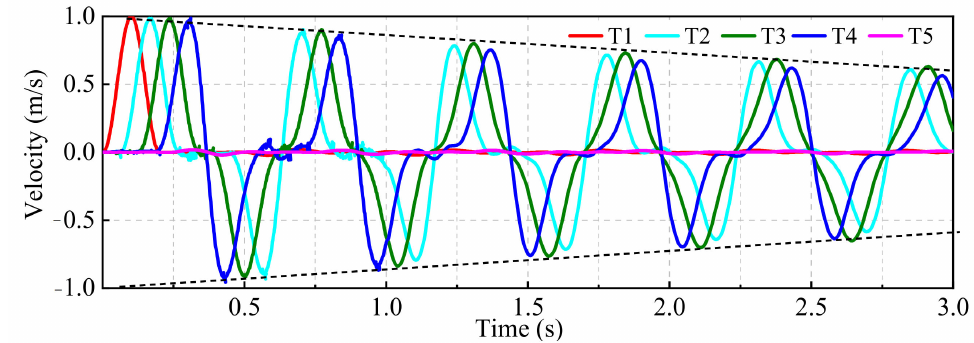
Figure 4. Horizontal velocity history of measuring points with a fixed